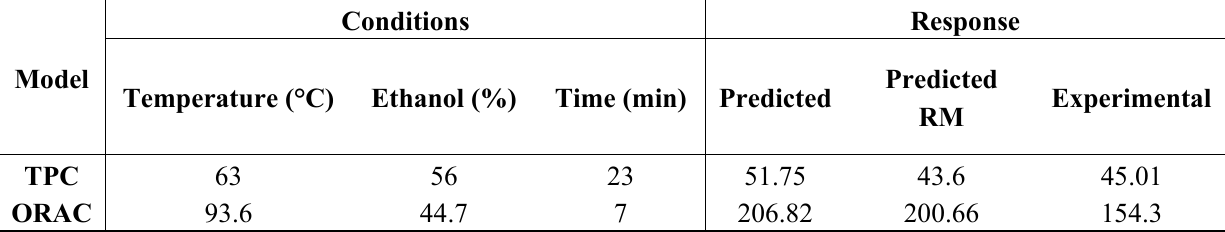
Table 4. Optimal conditions for the extractions for TPC and ORAC, given by